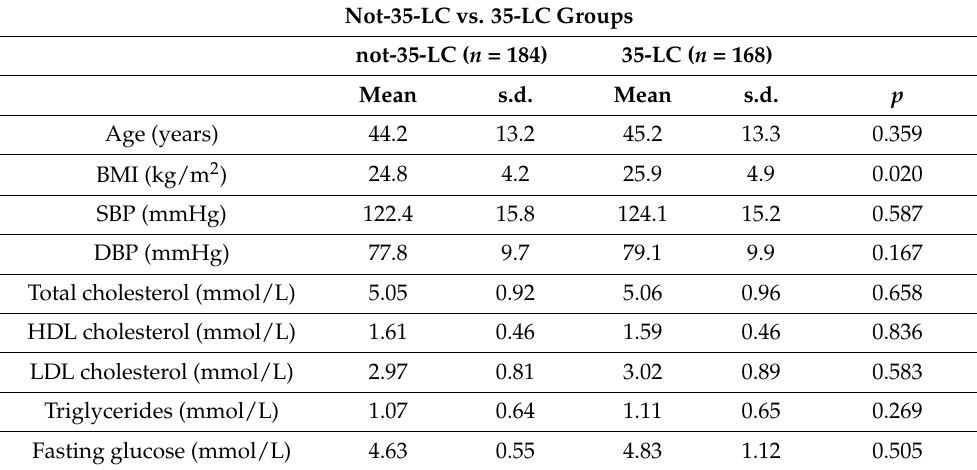
Table 4. Comparison of mean age, BMI, blood pressure and hematochemical parameters between non-35-Long-COVID and 35-Long-COVID patients. Not-35-LC vs. 35-LC